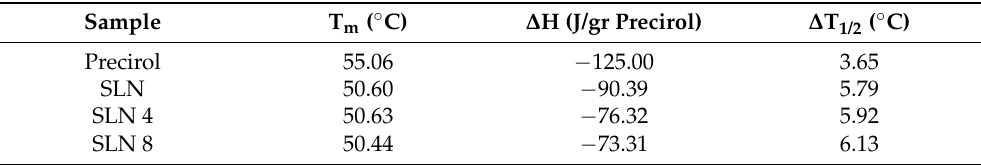
Figure 2. Calorimetric curves, in heating mode, of Precirol, SLN, SLN 4 and SLN 8. Table 5. Transition temperature (T m ), enthalpy variation ( ∆ H) and peak width at half height ( ∆ T 1/2 ) of Precirol, SLN, SLN4 and SLN8.